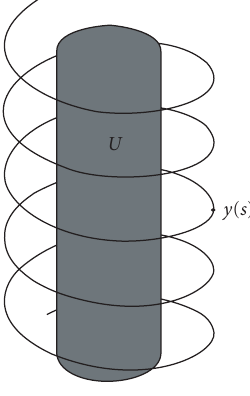
Figure 1: The spiral and image space U .